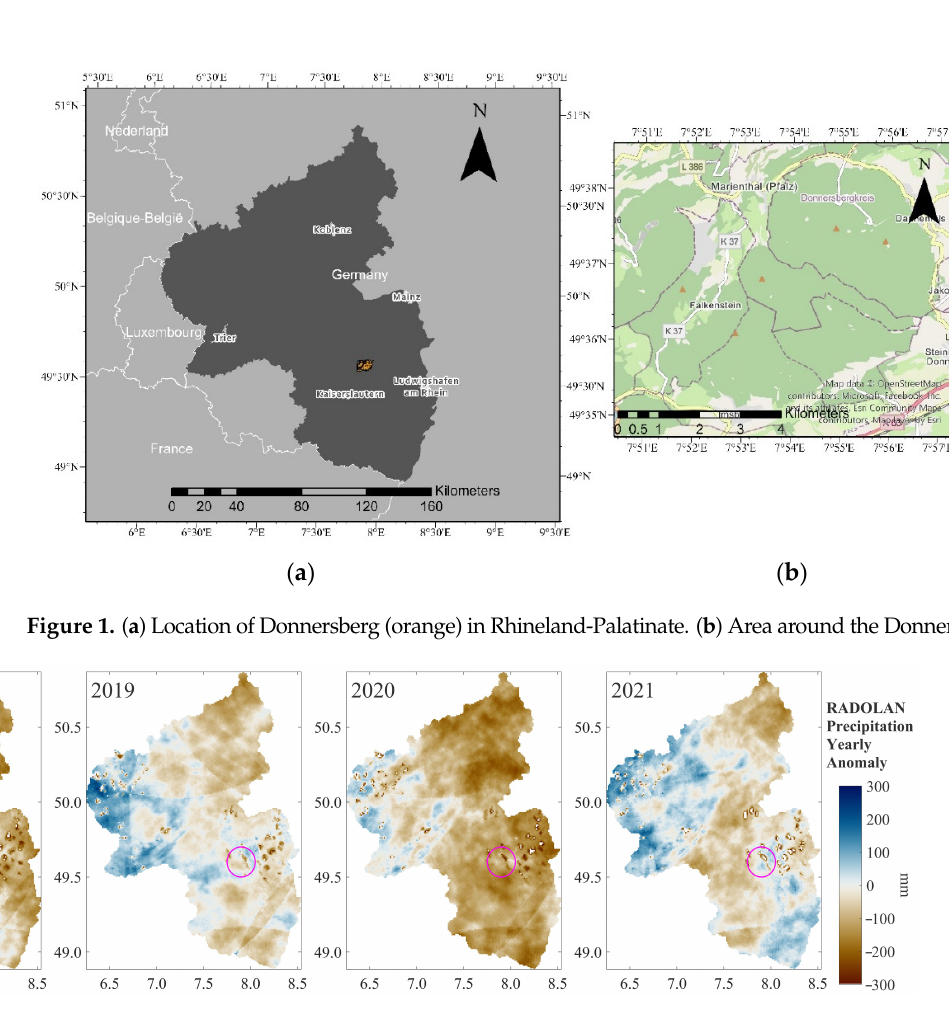
Figure 2. Precipitation Anomaly in RLP for the years 2018 to 2021 in comparison to the mean (2007 to 2021), the Donnersberg area is circled. Data source: German Weather Service DWD [31].